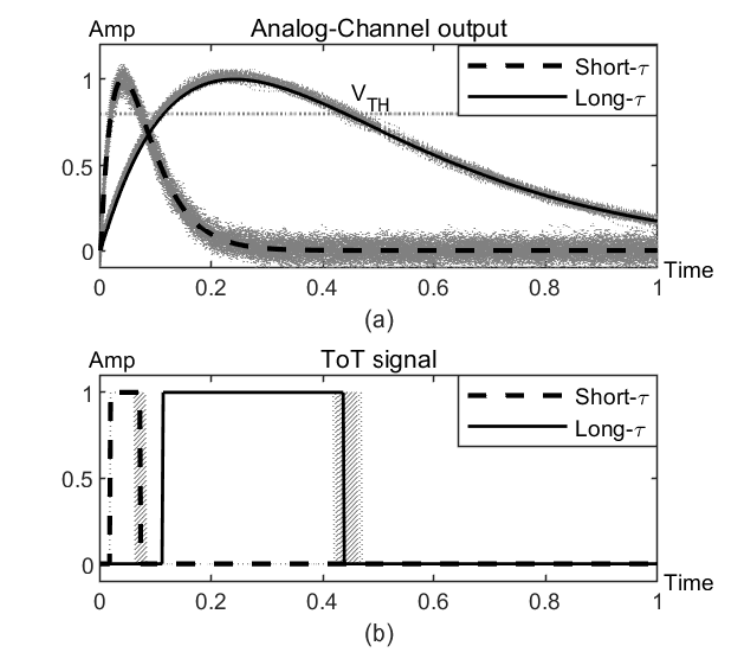
Figure 4. ( a ) Time domain outputs of the two analog-channels with different τ specifications; and ( b ) extracted ToT signals from the analog-channel output.